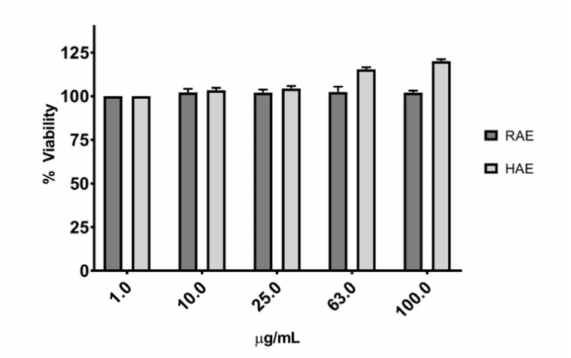
Figure 3. Viability of HDFa cells exposed to MS extracts at concentrations of 1 µ g/mL to 100 µ g/mL for 24 h. These results prompted us to use the RAE and HAE extracts at concentrations between 63 and 100 µ g/mL for infection assays on HDFa